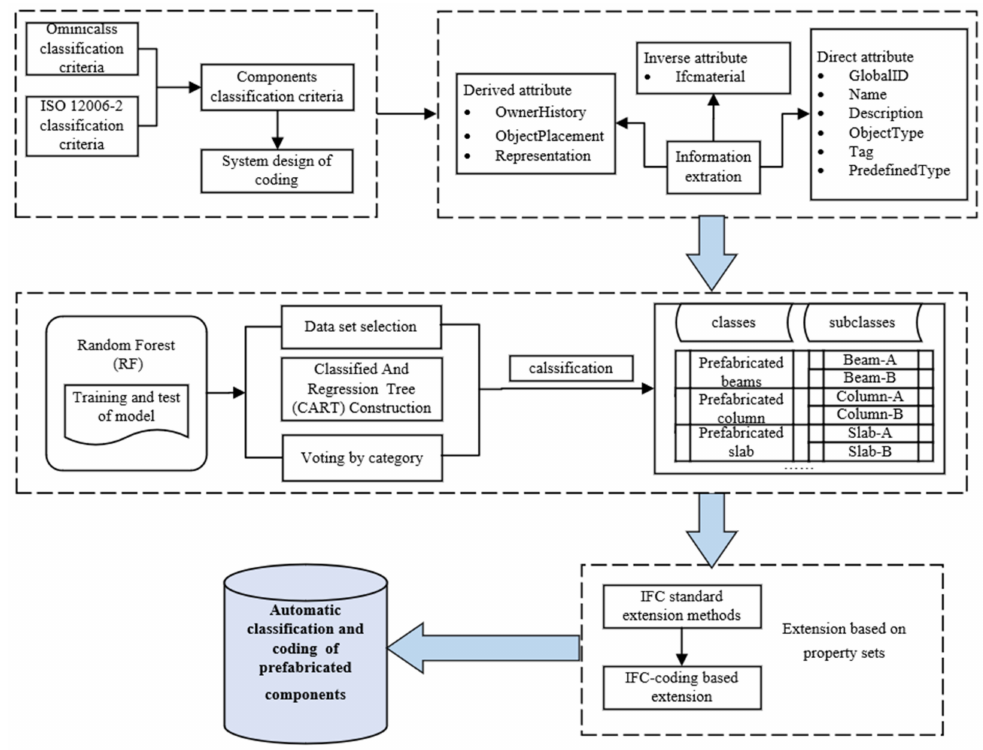
Figure 1. Overall Research